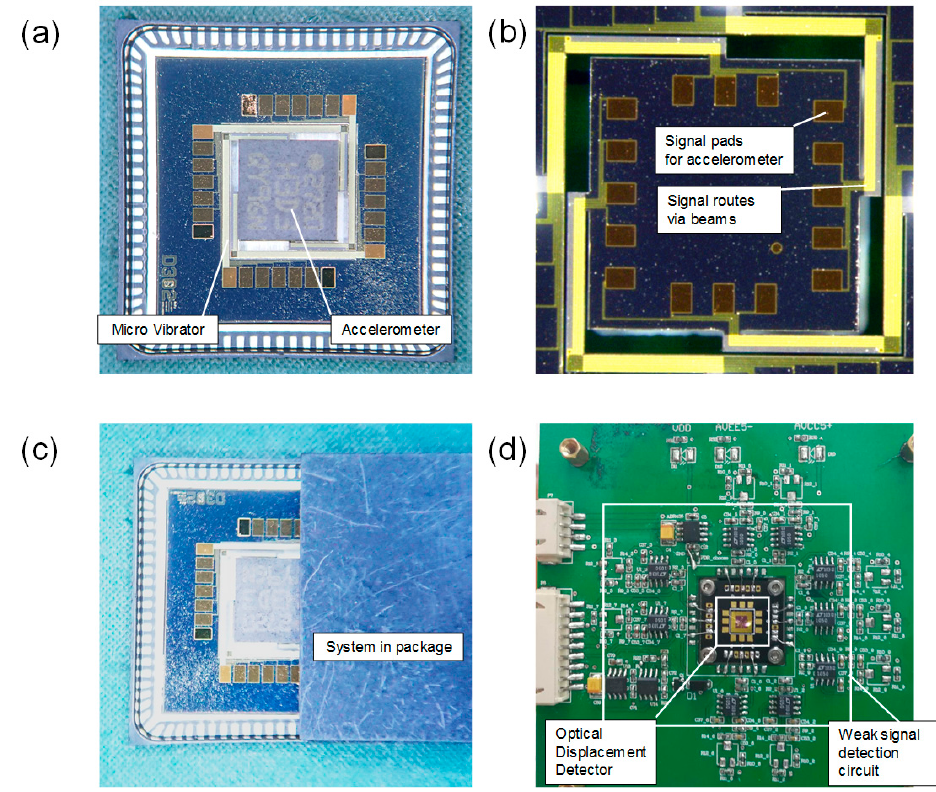
Figure 5. The photos of ( a ) the micro-vibrator with an accelerometer payload, and a light reflector is on the top surface of the accelerometer; ( b ) the micro-vibrator without the accelerometer; ( c ) a system-in-package solution for self-calibration; ( d ) an optical detector with its peripheral signal processing circuit.